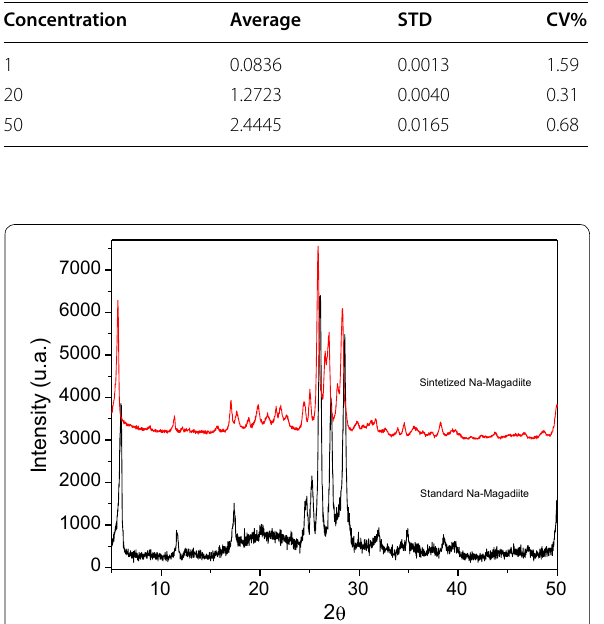
Fig. 2 X-ray diffraction patterns for the synthesized and standard Na-magadiite